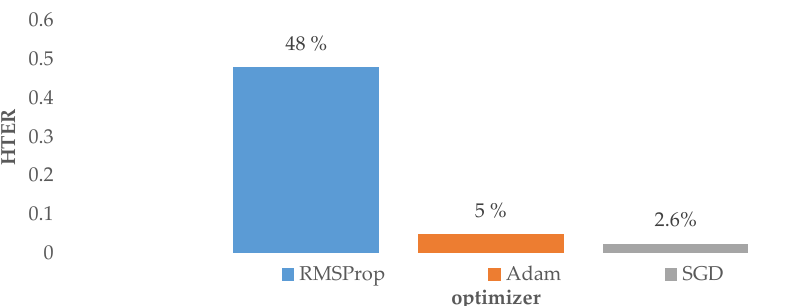
Figure 8. Impact of the optimizer in the transfer-learning-based model in terms of HTER (the lower the better).